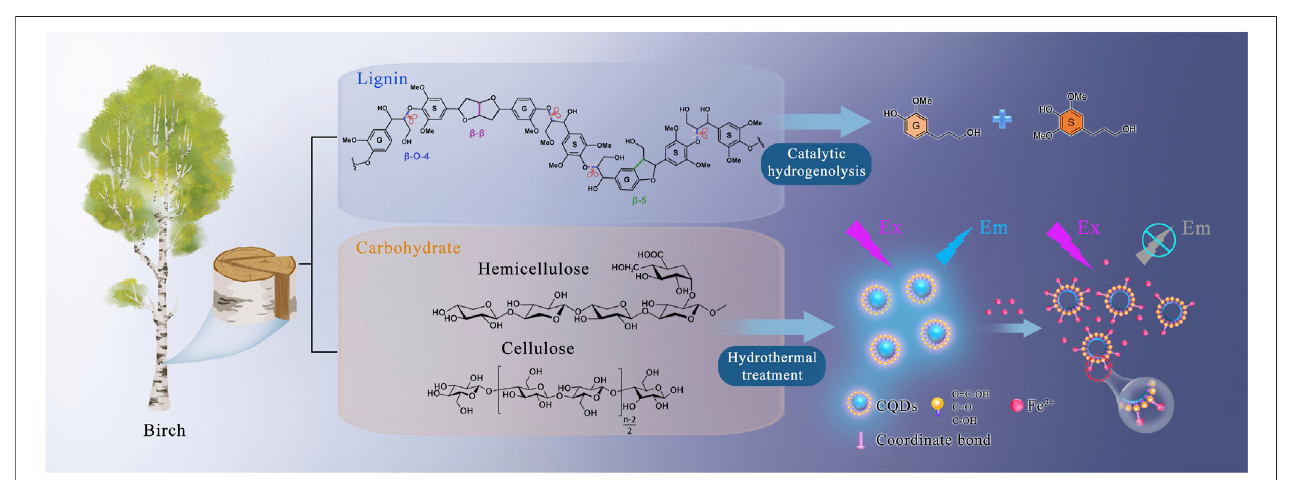
FIGURE 6 | Schematic diagram for the reductive catalytic fractionation (RCF) of birch and the preparation of fl uorescent CQDs.